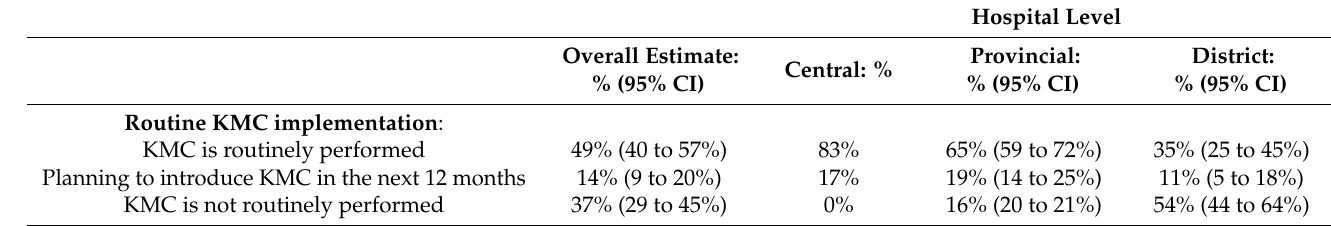
Table 1. Implementation of Kangaroo Mother Care (in all participating